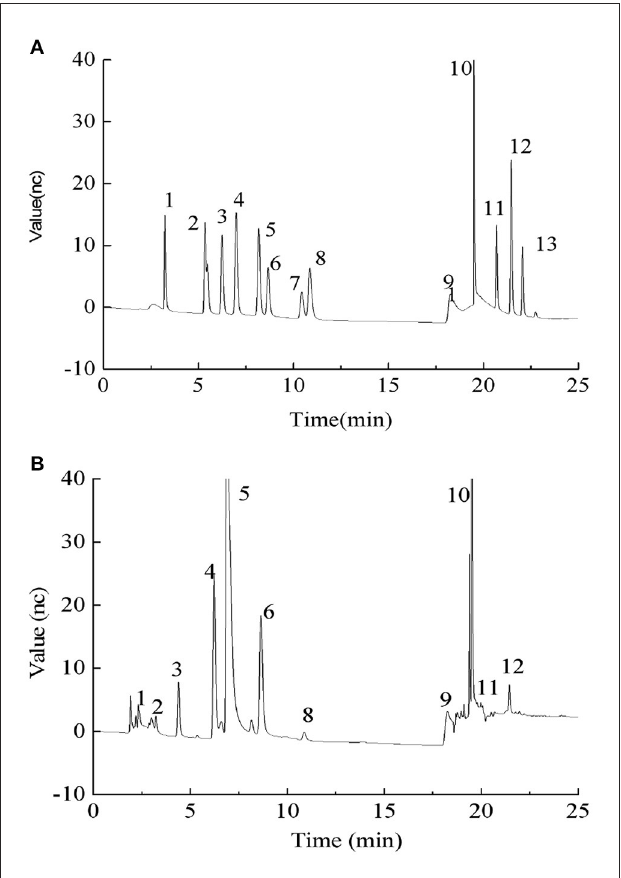
FIGURE1 (A) Ion chromatography (ICS) profiles of monosaccharide standards. Monosaccharide standards 1–13 were as follows: (1) fucose, (2) arabinose, (3) galactose, (4) glucose, (5) xylose, (6) mannose, (7) fructose, (8) ribose, (11) galacturonic acid, (12) glucuronic acid, (13) mannuronic acid, and (9 and 10) the elution solvent; (B) Monosaccharide composition of PEPs.